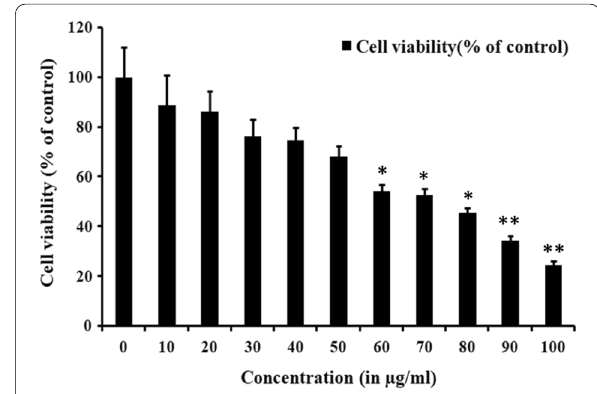
Fig. 4 Effect of HCA on cell proliferation and viability of RAW 264.7 cells. Cells were treated with increasing concentrations of HCA for 24 h; cell viability was determined with MTT cell proliferation reagent. Results were expressed as cell viability (% of control). All data are expressed as mean SEM (n 3). * p < 0.05, ** p < 0.01 and *** p < 0.001 ± = vs. 0 μM. The IC